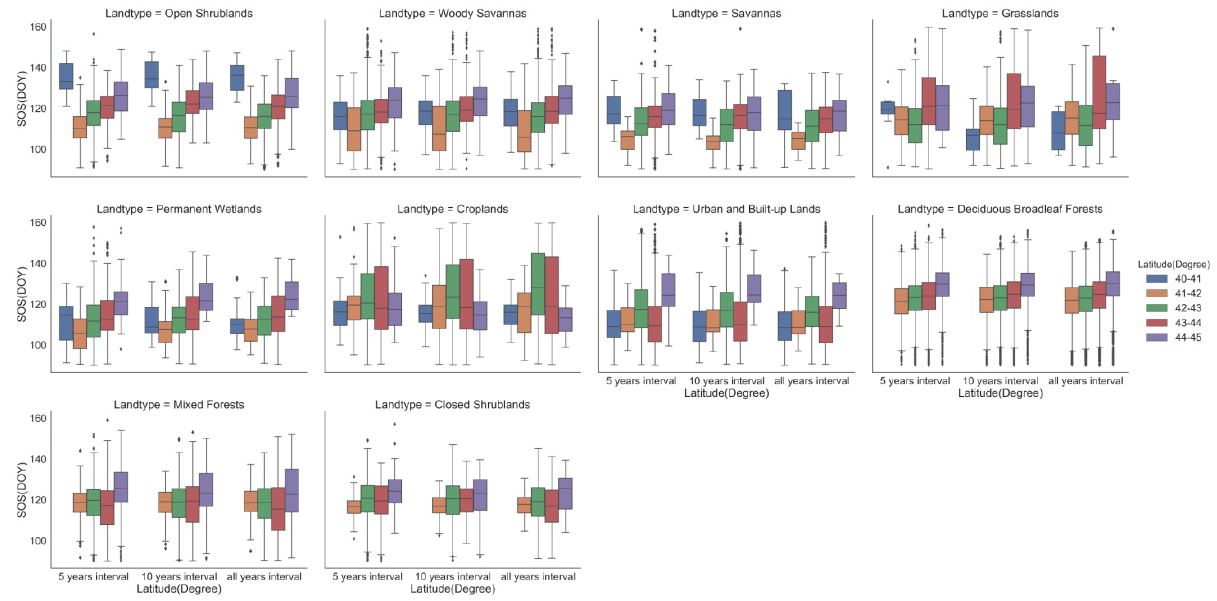
Figure 3. LSP SOS results in different time